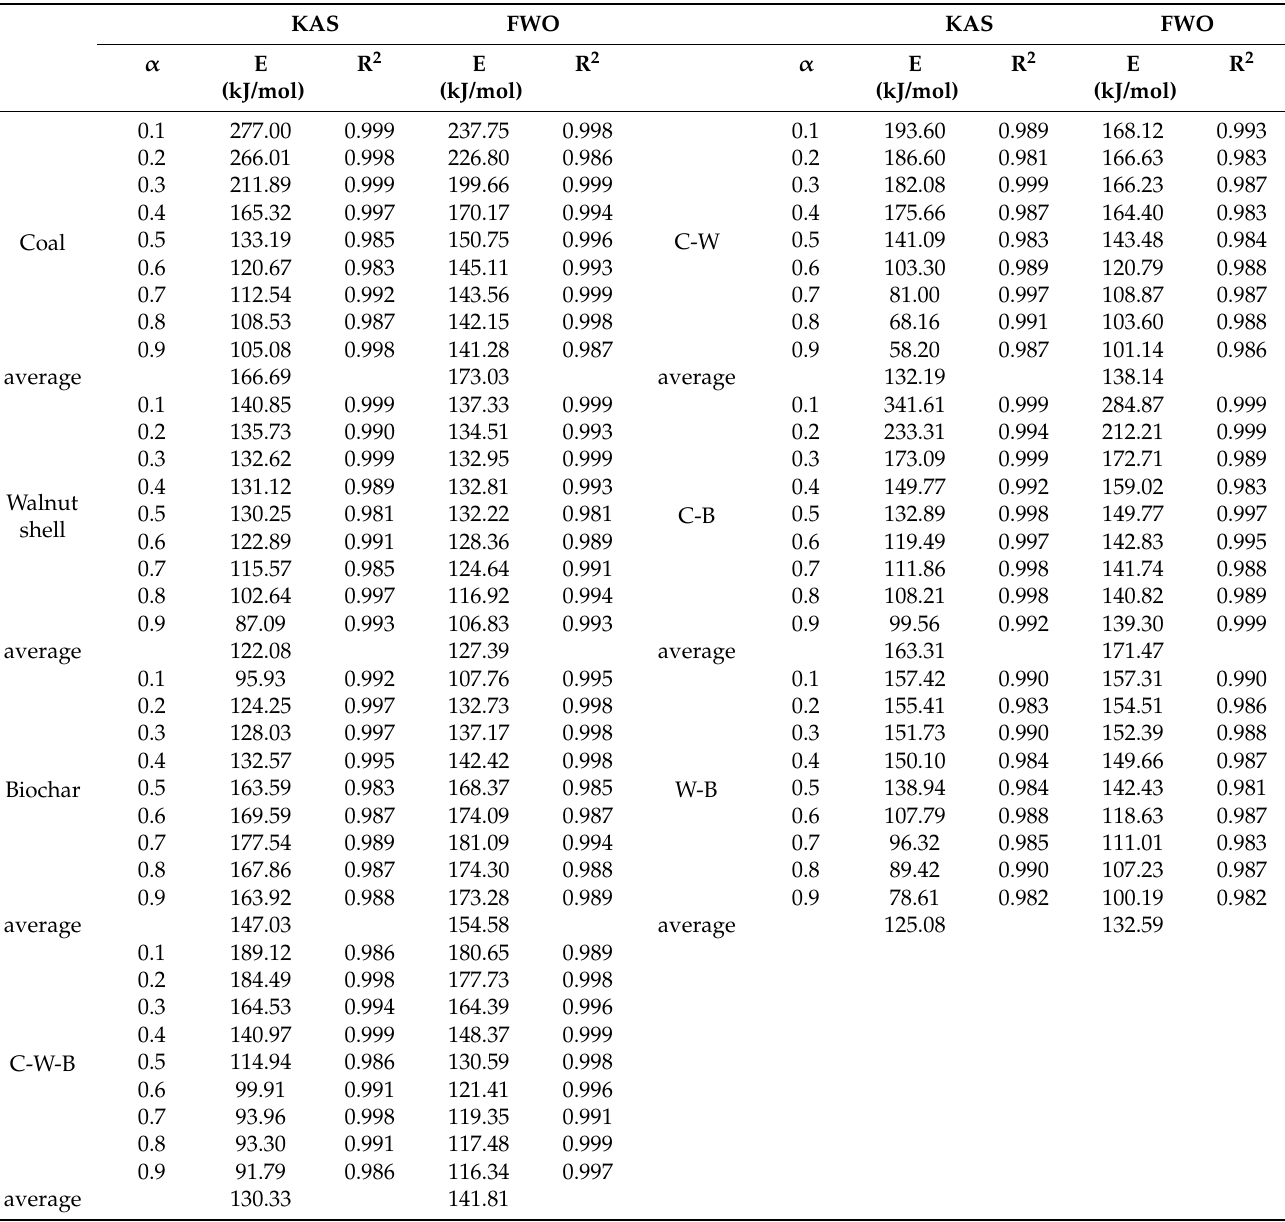
Table 4. Combustion kinetic parameters at different conversion degrees determined using the KAS and FWO